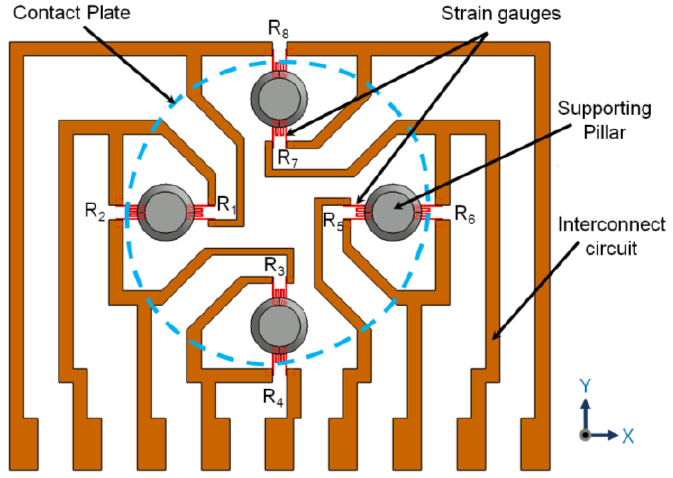
Figure 2. Schematic representation of the configuration of the resistor and interconnects. Eight strain gauges are candidates for quarter-bridge or moment-compensation circuit. Four strain gauges (R , R , R , and R ) were used to measure applied normal and 1 3 5 7